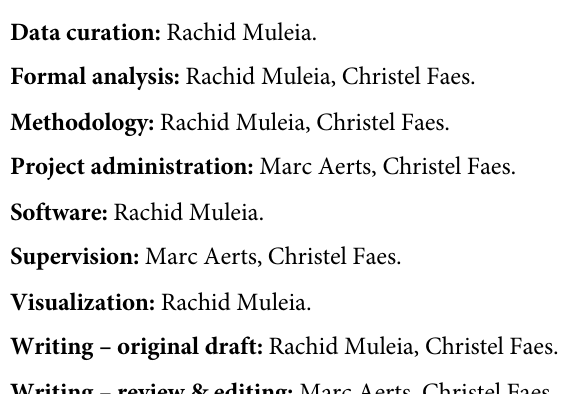
2. This model assumes that incubation period and infectious period do not vary across the dis- tricts. The black dots represent the observed incidence data. S3 Fig. Effective reproductive number for model 3 under weakly informative prior. Effec- tive reproductive number(black solid line) with its 95% credible interval. The horizontal red line corresponds to R = 1. The vertical red line indicates where exactly the epidemic starts. t These results correspond to the model with weakly informative priors. The model assumes constant mean transmission rate, constant incubation and constant infectious period. The curves were produced based on Model 3. The black dots represent the observed incidence data. S4 Fig. Effective reproductive number for nationwide model under weakly informative prior. Effective reproductive number (black solid line) for the nationwide EVD data with its 95% credible interval. The horizontal red line corresponds to R = 1. These results correspond t to the model with weakly informative priors. The black dots represent the observed incidence data. S5 Fig. Ebola incidence data versus simulated data from a stochastic epidemic model con- sidering a constant transmission rate. Stochastic simulation of the incidence data from the marginal posterior distribution of ( β , 1/ % , 1/ γ , E (0), I (0)). The data are simulated for the first 17 weeks of the epidemic as the assumption of constant transmission rate applies for the early phase of the epidemic. The out break reaches the peak at week 17. The blue curve represents the observed EVD incidence